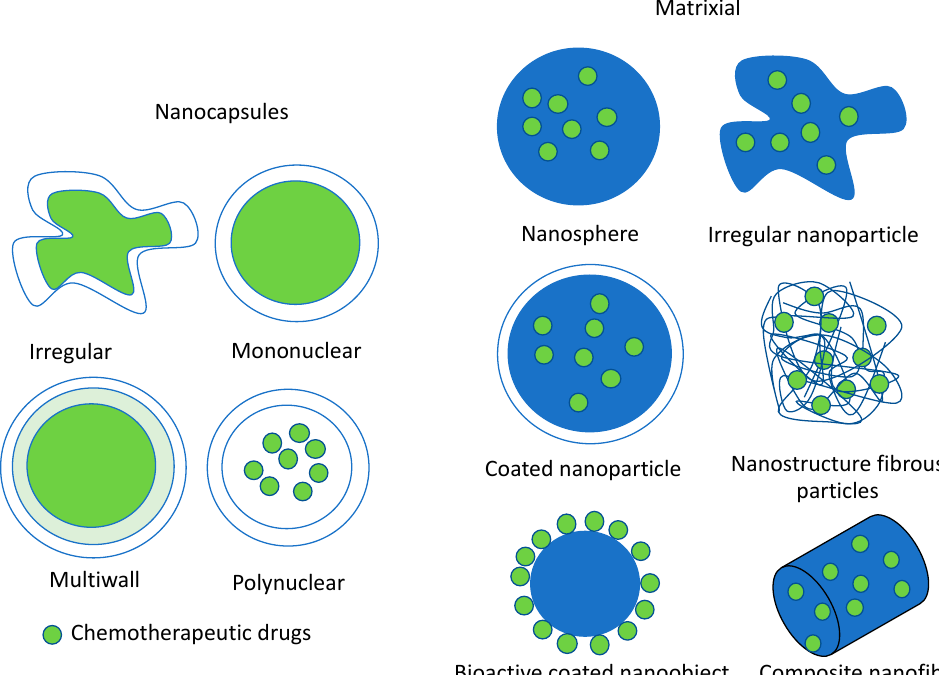
Figure 5. Nanodevices for the encapsulation of chemotherapeutic drugs /